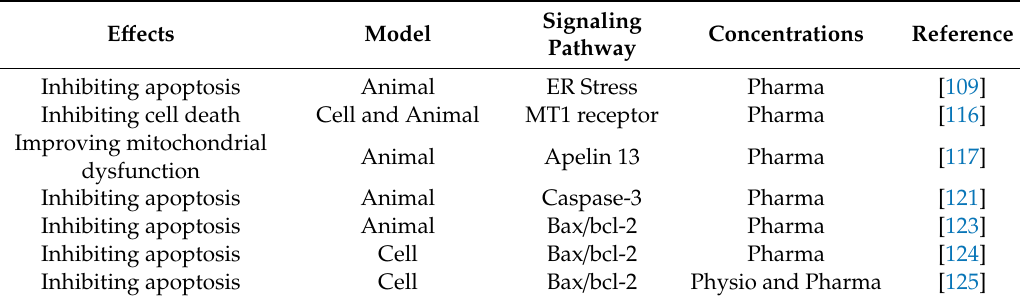
Table 3. Melatonin and Huntington’s